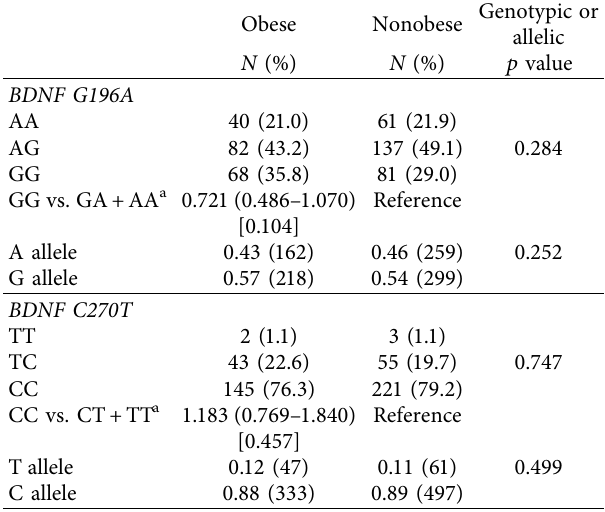
a Values are the odds ratio with 95% confdence interval in parentheses; p values are in brackets.